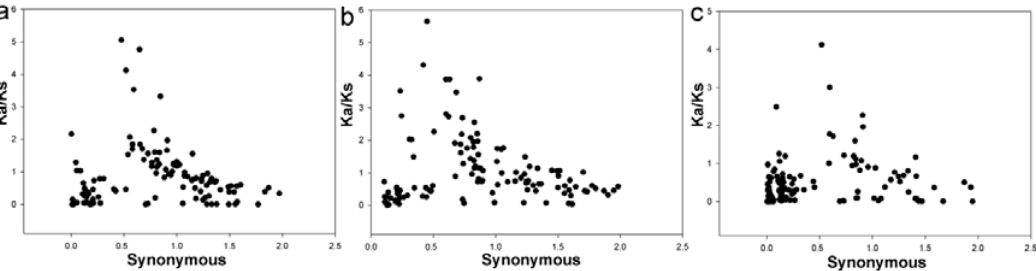
Figure 4. The distribution of Ka (nonsynonymous), Ks (synonymous), and Ka/Ks values of paralogous and orthologous gene pairs. ( a – c ) represent Pbr ‐ Pbr, Pcp ‐ Pcp, and Pbr ‐ Pcp gene pairs, respectively. The X ‐ and Y ‐ axes denote the synonymous distance and Ka/Ks ratio for each pair, respectively.